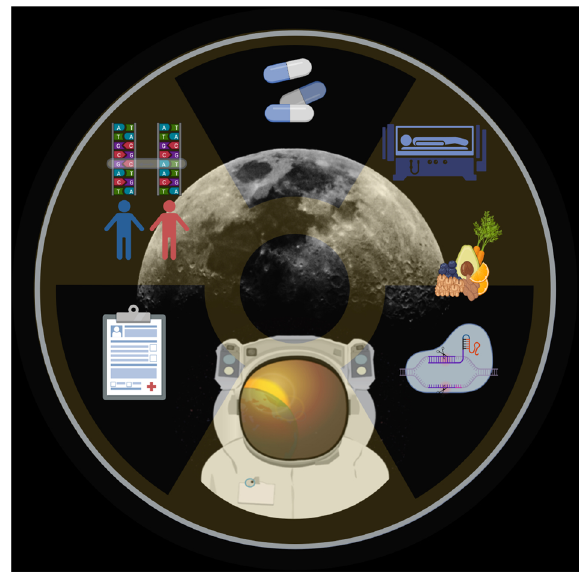
Fig. 3 Principles of interventions to reduce health risk from space radiation exposure (clockwise from lower left). Selection cam- paigns — genome-wide association studies — radioprotective phar- maceuticals — hibernation (synthetic torpor) 49 — food supplements — genome editing. Illustration created by the authors for this